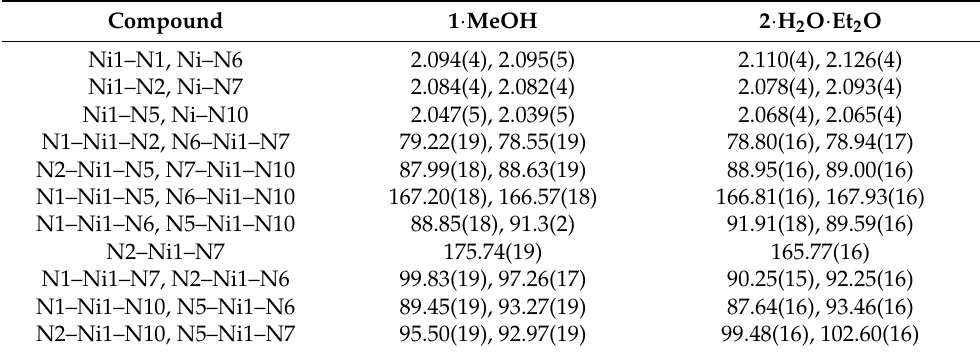
Table 2. Selected bond lengths ( l /Å) and angles ( ɸ /°) around the Ni II center in compounds 1 ·MeOH and 2 ·H 2 O·Et 2 O.